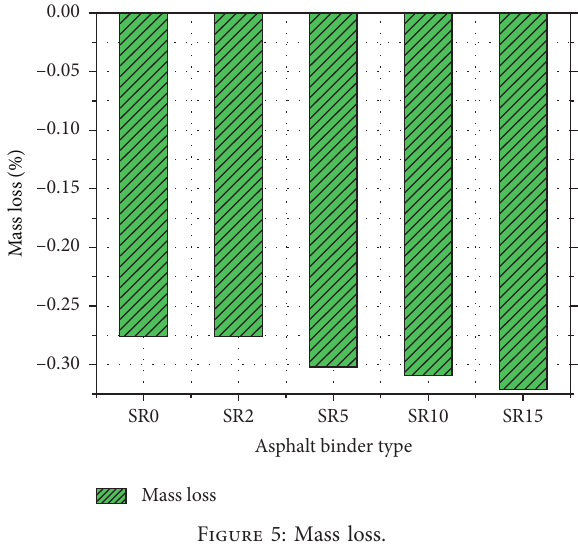
Figure 5: Mass loss.